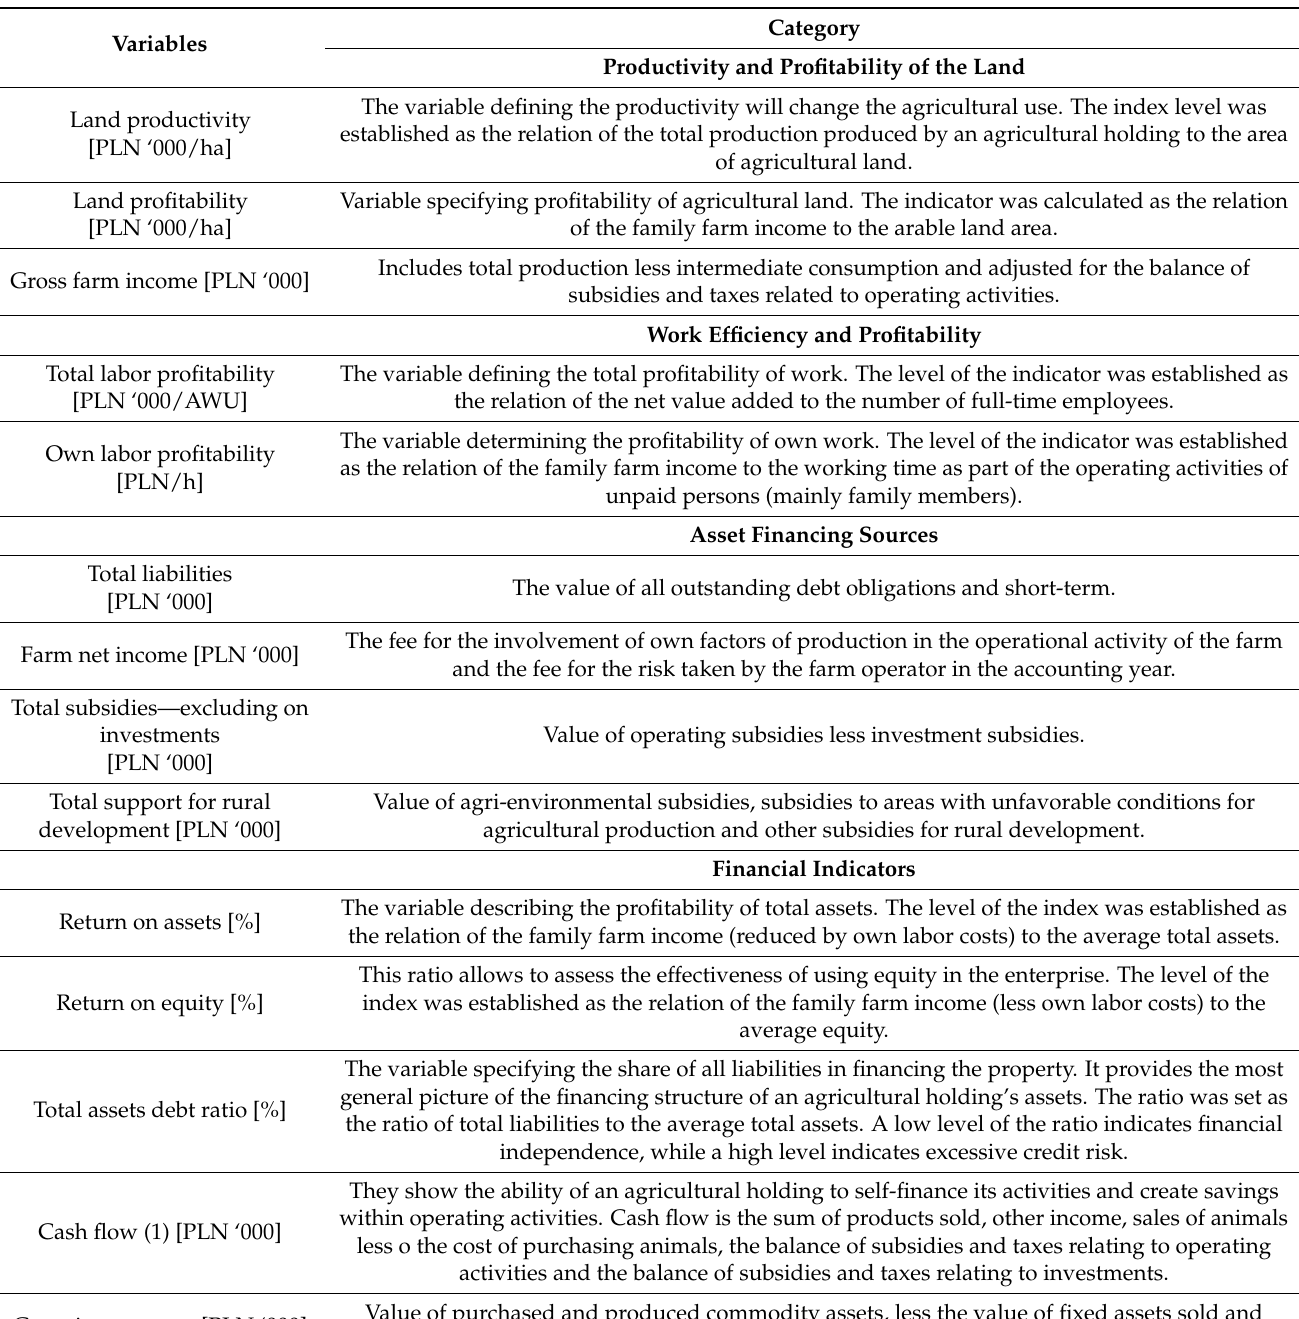
Table 2. Diagnostic variables included in the study of economic results of small